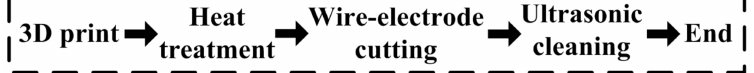
Figure 4. Post processing steps for pre-printed tensile